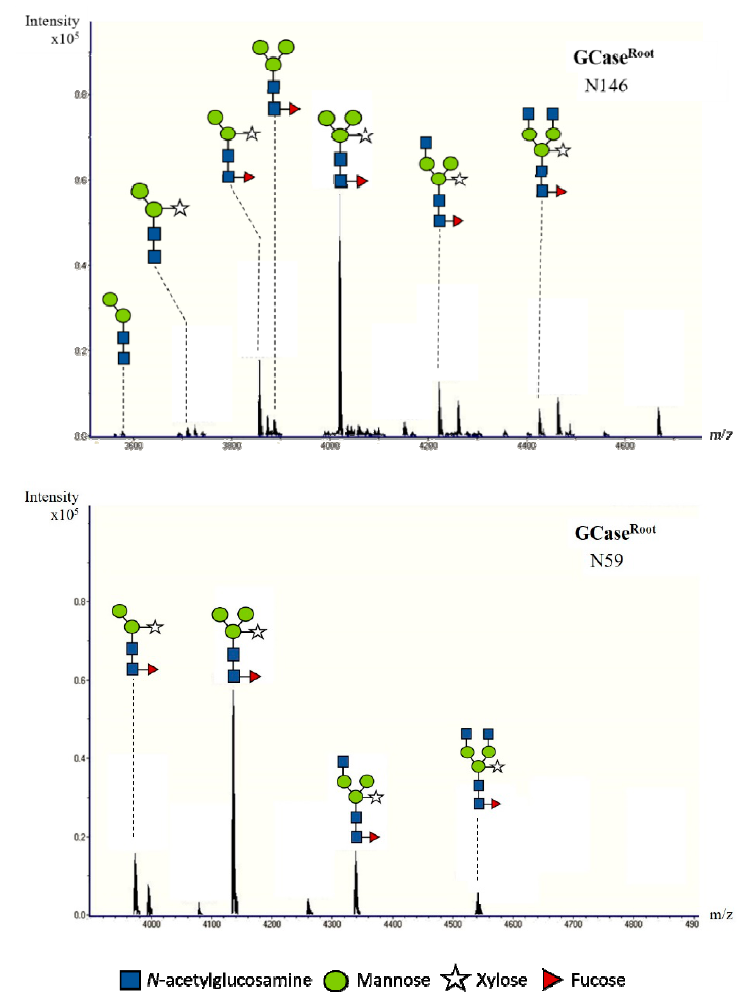
Figure 5. N -glycan analysis of purified GCase using nano LC/MS. The glycopeptides with N -glycosylation at positions N59, N146 and N270 are shown. Table 1. Composition of the N -glycan structure attached to purified GCase from leaves [24] and purified GCase from root culture.